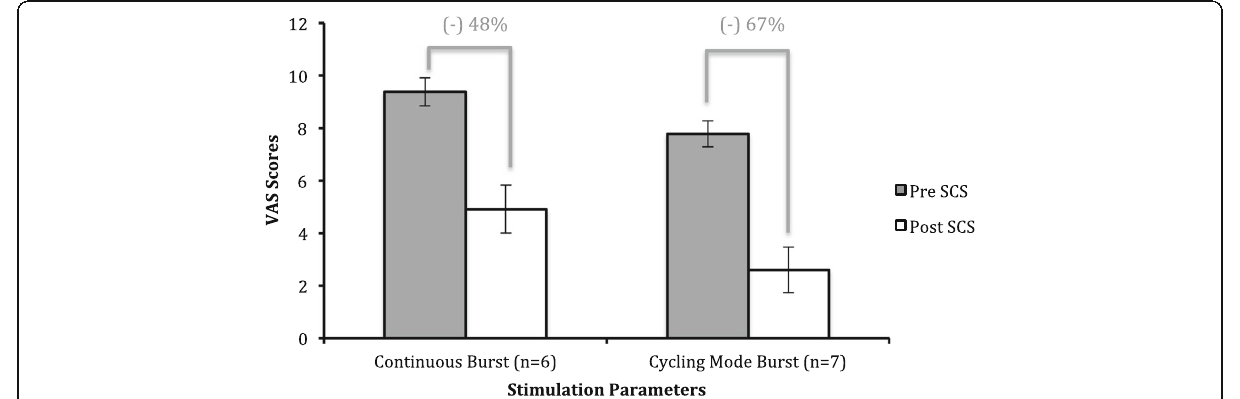
Fig. 2 Pre and Post VAS Scores Stratified by Stimulation